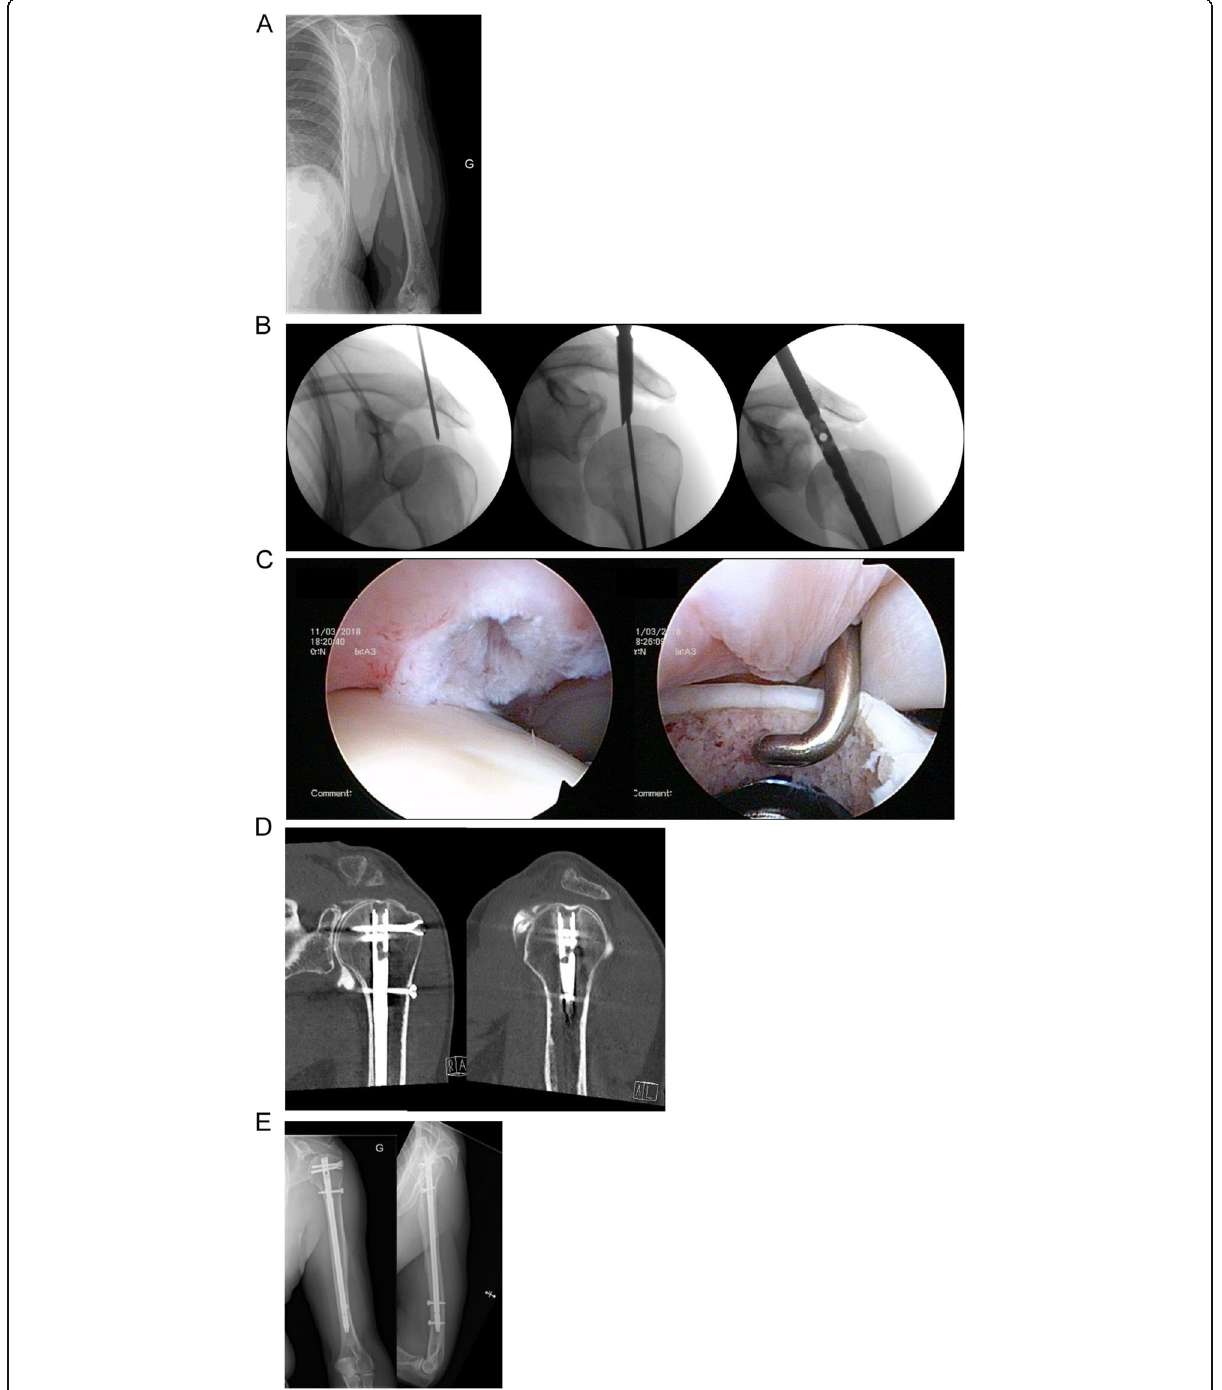
Fig. 5 Male patient, 57 years, sustained a diaphyseal spiral fracture after a fall from stairs ( 1a ). Three intraoperative views with the image intensifier: insertion point and direction was determined using a 2.0 mm Kirschner wire. After the feasibility has been verified a cannulated awl is used to perforate the supraspinatus tendon and the articular surface. With the awl in situ the Kirschner is removed and replaced by a long guide wire which then directs the nail ( 1b ). After stabilisation a diagnostic arthroscopy is performed to document the perforation of the rotator cuff, the appropriate depth of the nail and to exclude concomitant intraarticular lesions ( 1c ). Five months after surgery a CT with intraarticular application of contrast medium was performed; a leakage or lesion to the rotator cuff was excluded ( 1d ). Bony consolidation at 6 months after surgery ( 1e